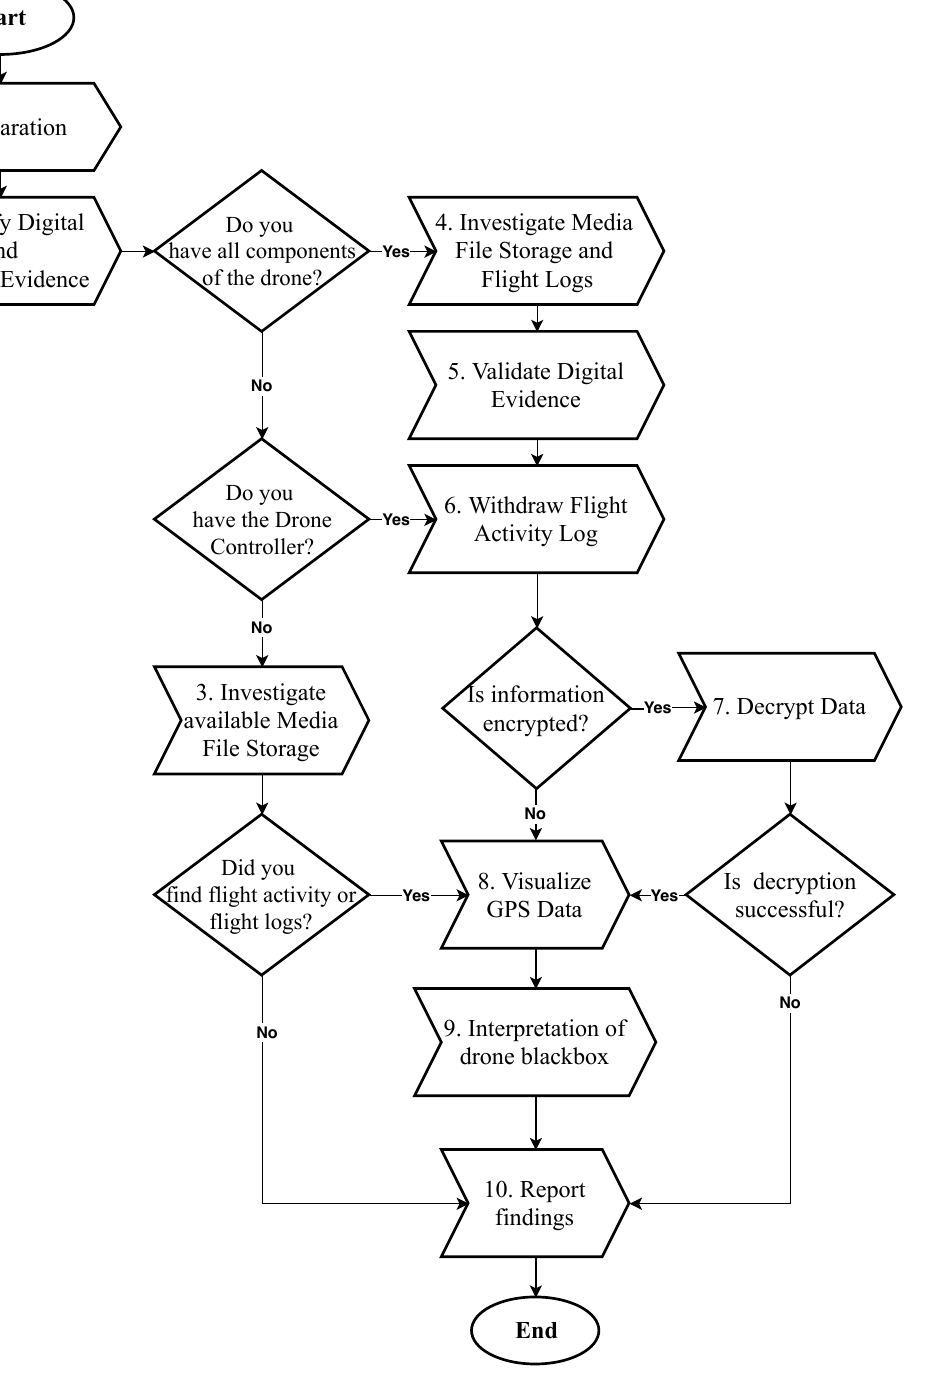
Figure 1. Proposed drone technical forensic investigation